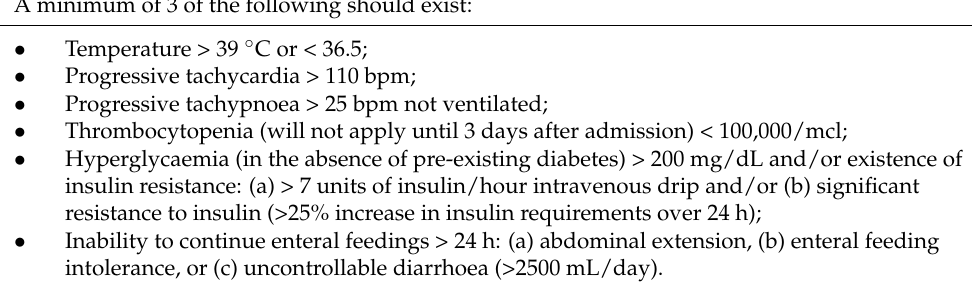
Table 1. Infection criteria in adult burn patients (according to the American Burn Association) [5]. A minimum of 3 of the following should